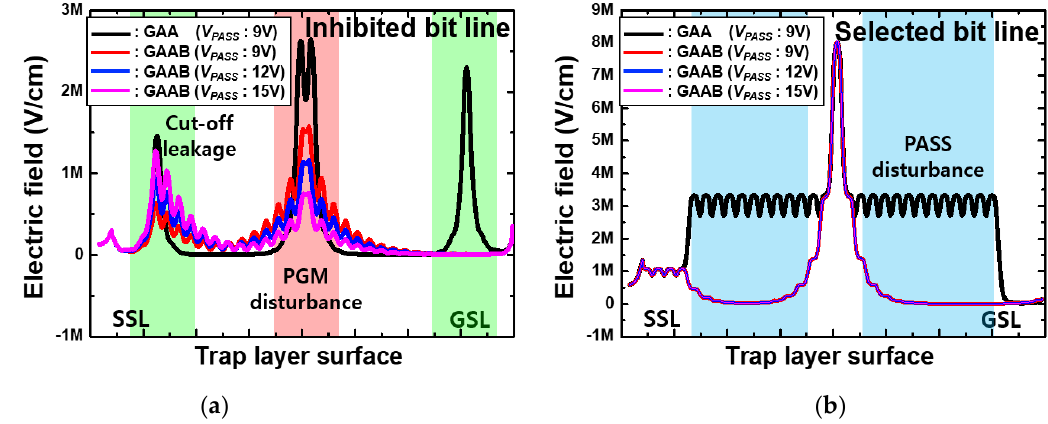
Figure 5. Electric field at t boosting in the nitride trap layer surface region of the NAND structure. ( a ) Inhibited BL and ( b ) selected BL.